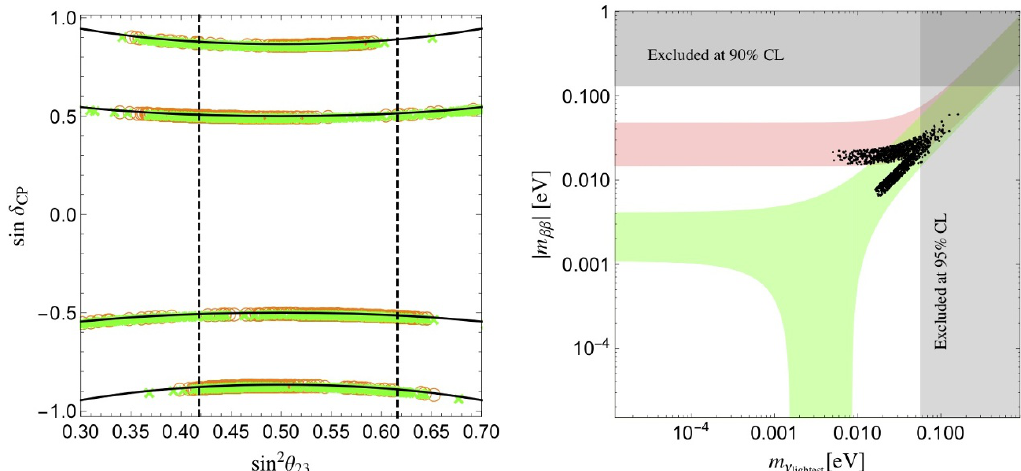
Figure 4 . Same as (cid:12)gure 3 but for n = 6 (with (cid:0) (cid:17) 1 = (cid:17) 2 = 1, (cid:13) = 1 and x = 1 ;